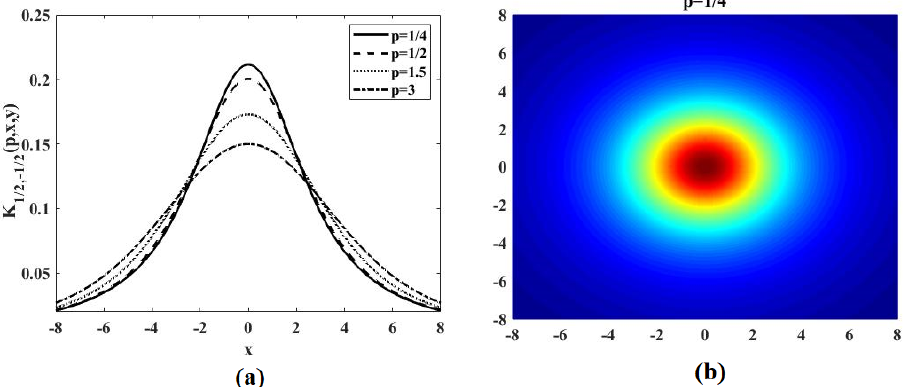
1/ 2, μ= 1/ 2 ν= − and 2.5. y = According to Figure 3a, the profile of the